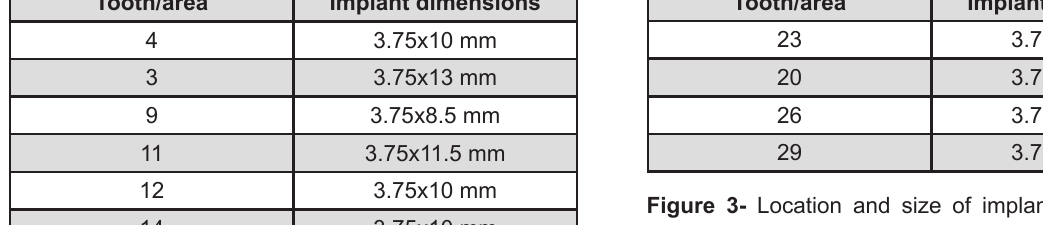
Figure 3- Location and size of implants placed in the patient’s mandible (Conexão, Conexão Sistemas de